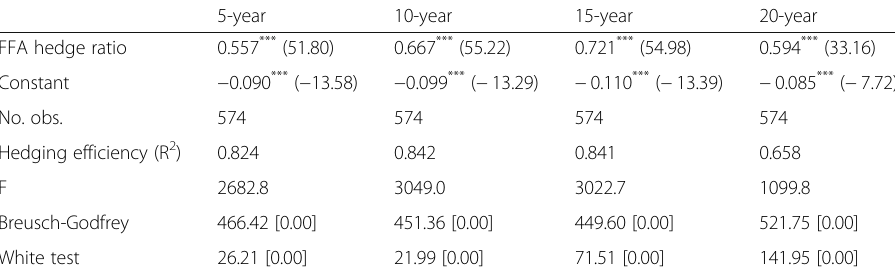
Table 4 Hedge ratio and efficiency across vessel